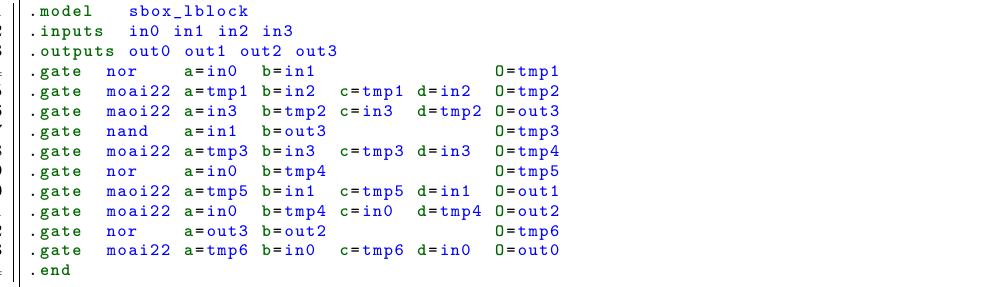
Figure 15: Area-optimized hardware implementation of LBlock S 0 Sbox using 19 GE with the standard cell library of the TSMC 65nm logic